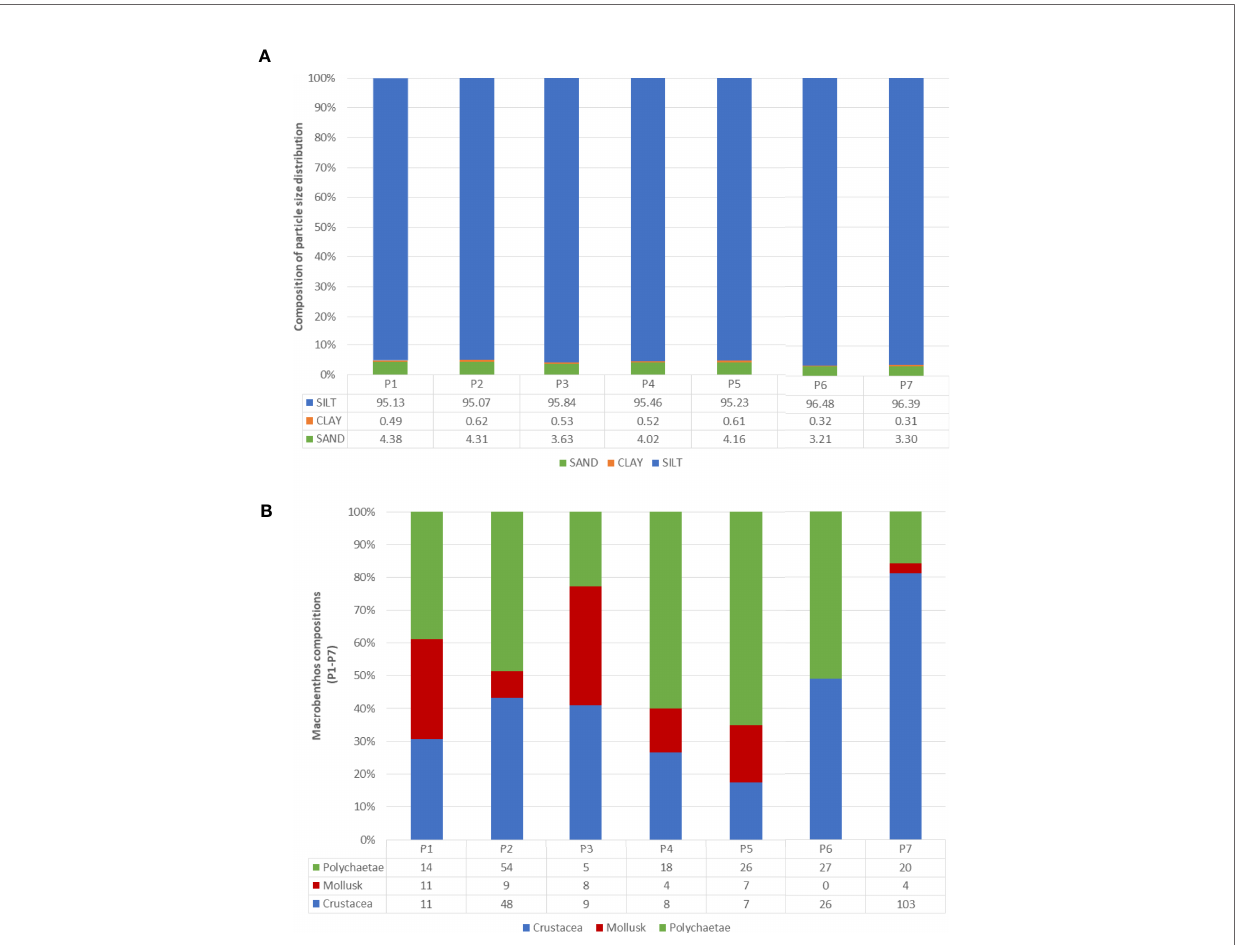
FIGURE 5 | Composition of (A) particle size distribution, (B) polychaetae, mollusk and crustacean